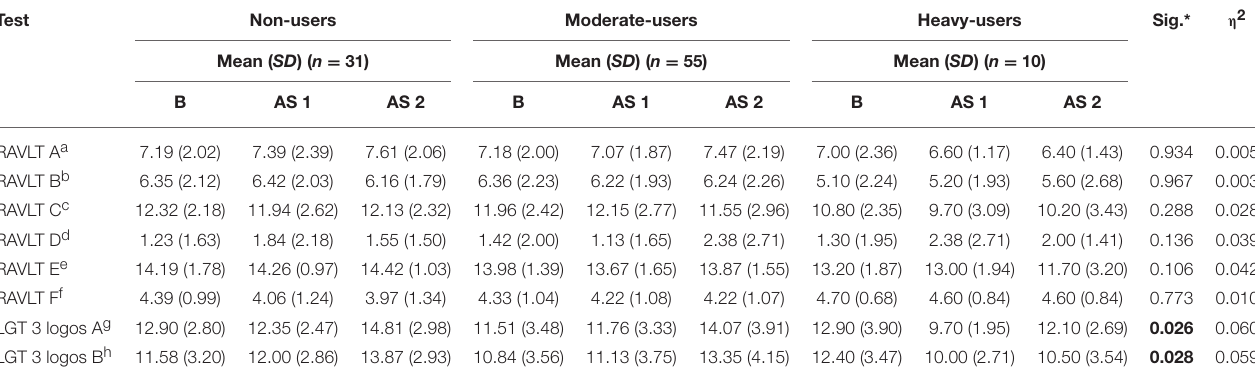
TABLE 5 | Mean Neuropsychological Test Score for 3,4-methylenedioxymethamphetamine (MDMA) users and non-users related to episodic